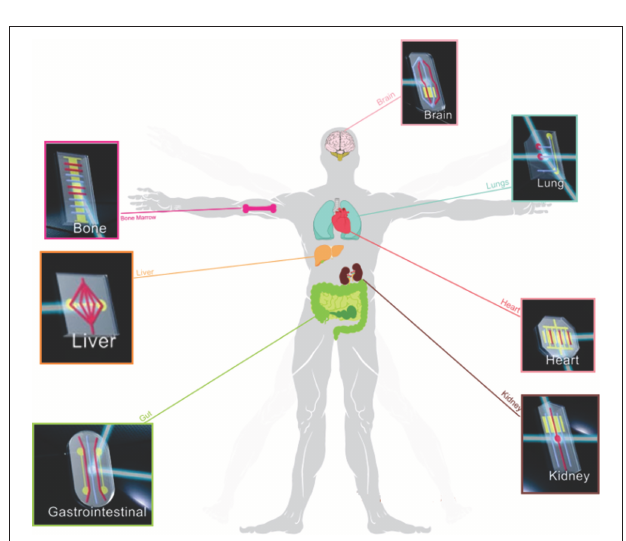
FIGURE 4 | Organs-on-a-chip.